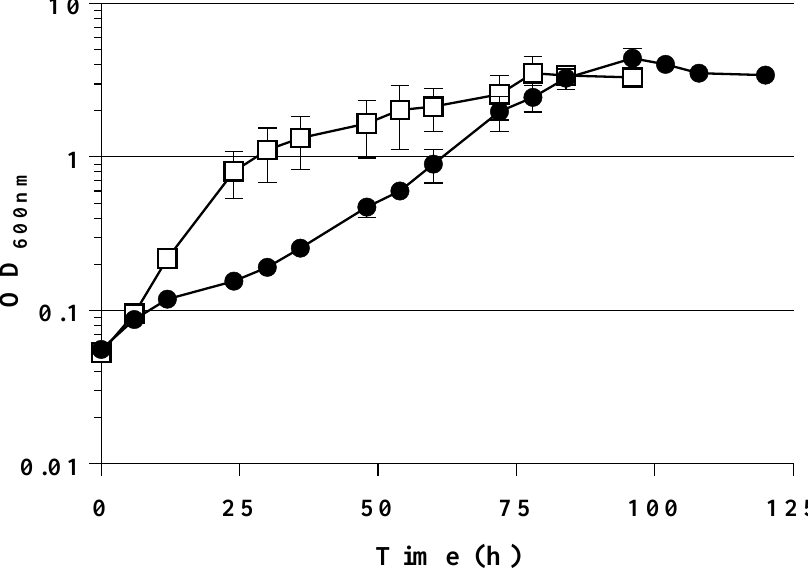
Figure 6. Growth behavior of GL3/pJF119 fsaA A129S (□) in comparison with GL4 (●). Shake flask growth on MM with glucose, 100 µM IPTG and, if appropriate, 100 µg/mL Amp. Precultures were on MM fructose and 100 µM IPTG to induce FSAA A129S activity already before the change of C source. Average values of two independent biological replicates are presented. Table 4. Consumption of di ff erent carbon sources and formation of DHA and glycerol in shake flask cultivations. All shake flask cultivations contained MM medium with 100 µ M IPTG. The